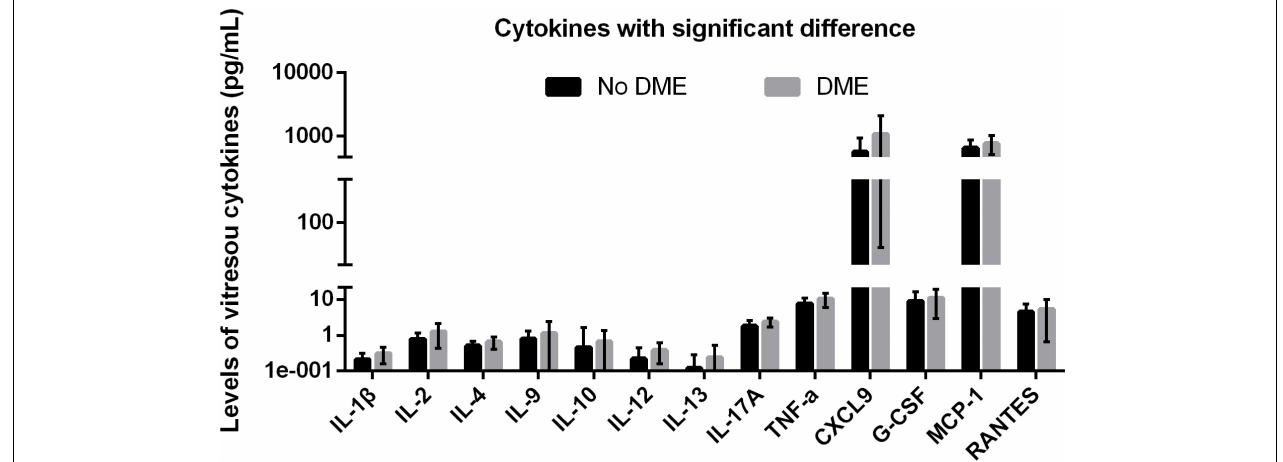
FIGURE 1 | DME-related upregulated vitreous cytokines with statistical significance. DME, diabetic macular edema.